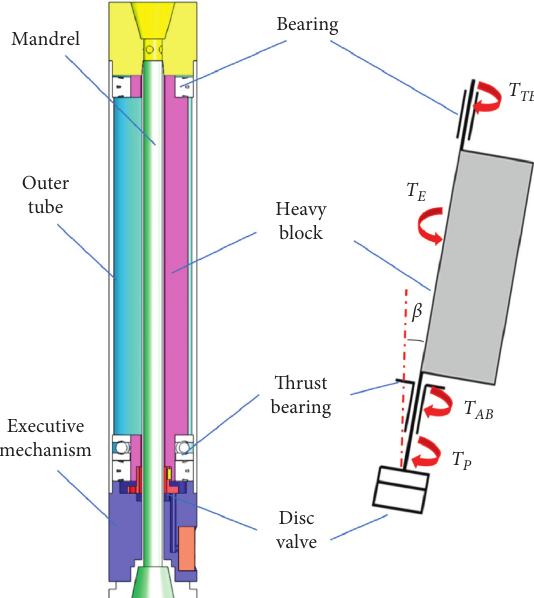
Figure 1: The force analysis model of the gravity sensing mechanism of the MAVDT.